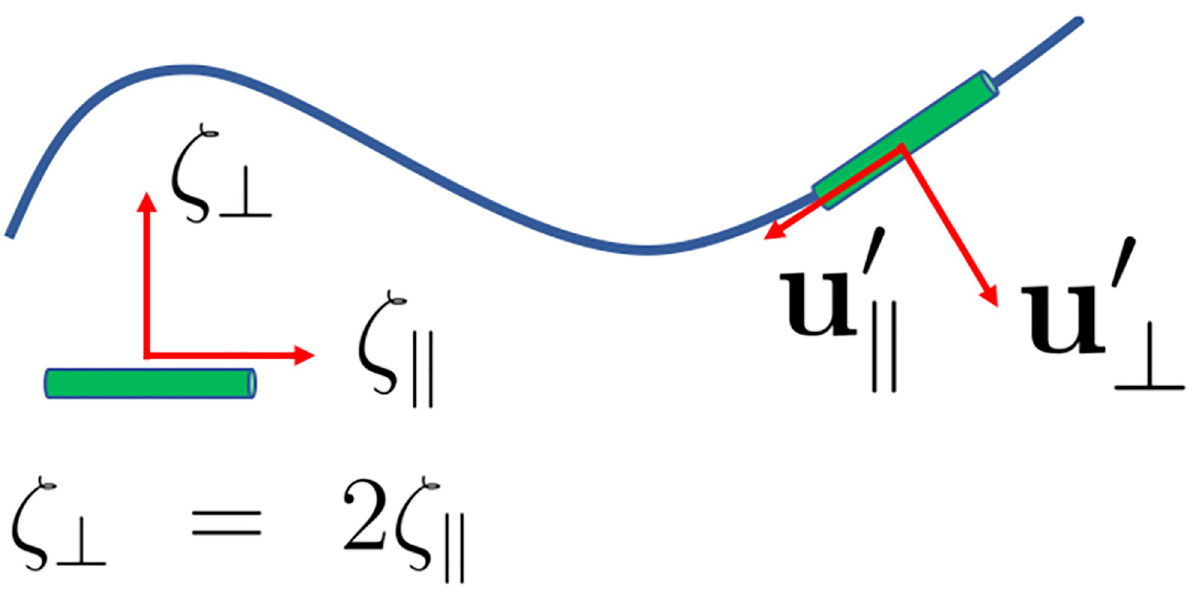
Fig 2. A schematic representation of the Resistance Force Theory (RFT) calculation. A flagellum, depicted by the blue line, is decomposed into small cylindrical segments moving at a velocity u 0 , which is decomposed as the sum of a tangential and a perpendicular component u 0 frame. The propulsive force is obtained by multiplying u 0